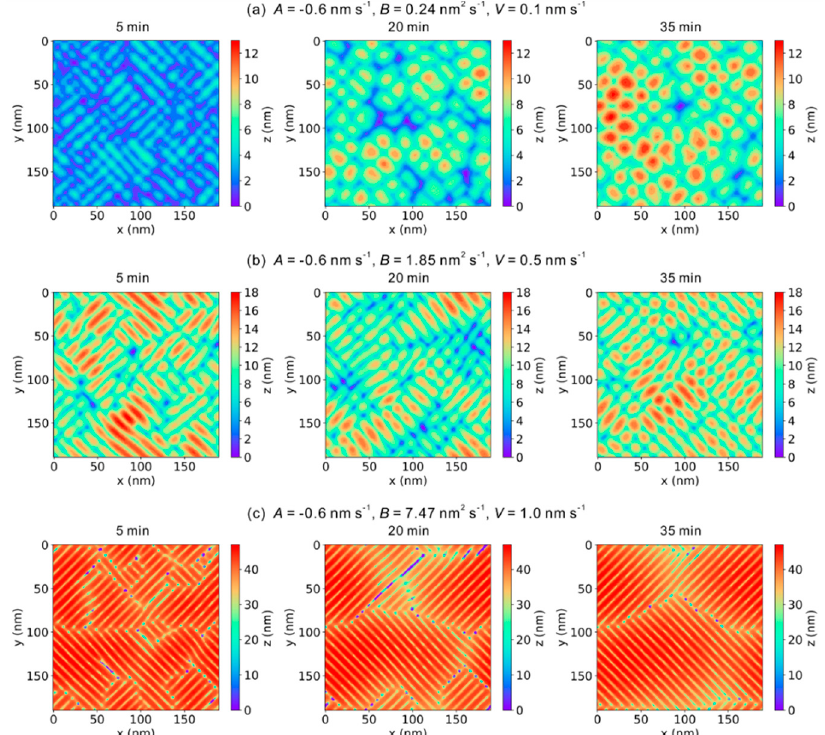
Figure 5. Heat maps of the surface height of thin films deposited with three different deposition rates corresponding to the incident vapor rate fixed as − 0.6 nm s − 1 and three different gas-solid transition velocities at three different deposition time of 5, 20 and 35 min due to the phase-field simulations.